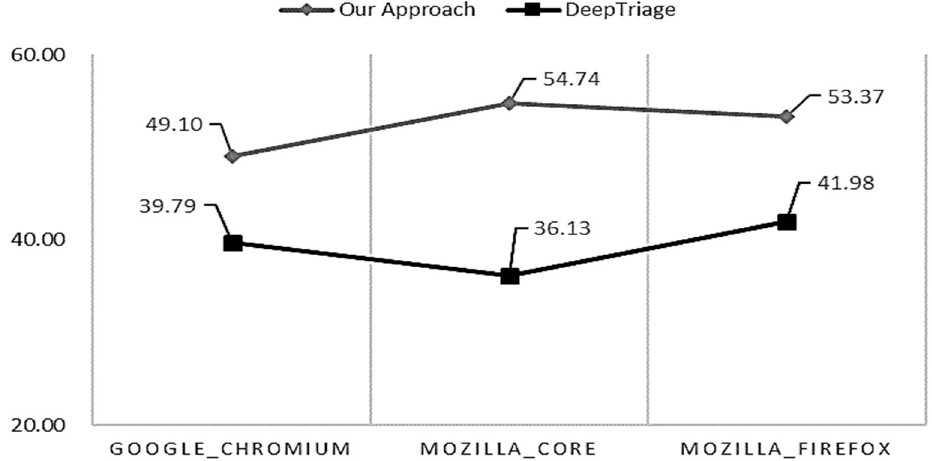
Figure 13. Performance comparison between baselines.